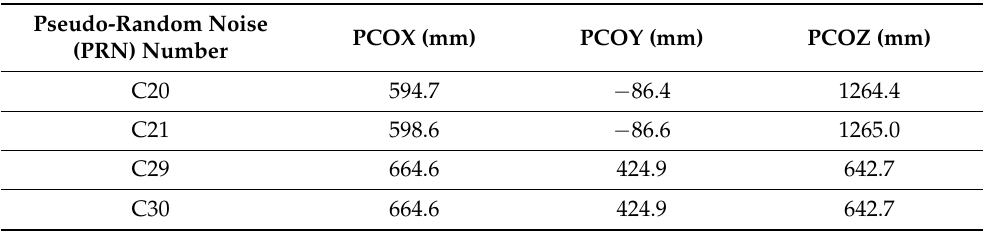
Table 2. The fundamental information and offsets of LRA’s effective phase center with respect to CoM for BDS-3 satellites [13].